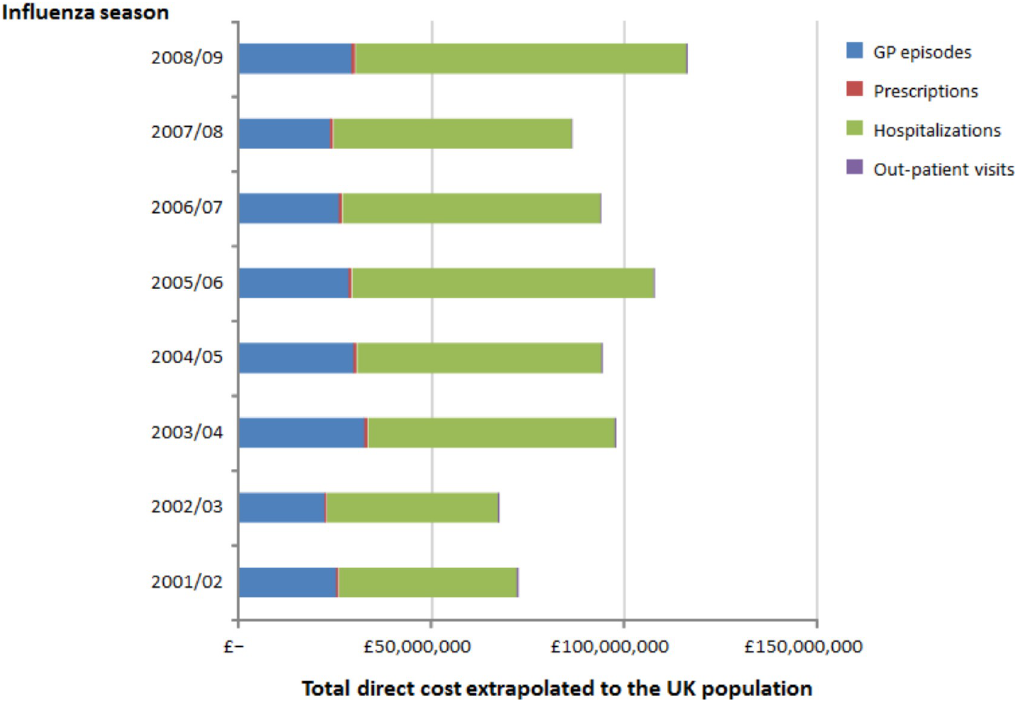
Fig 1. Resource use for acute respiratory illness in the CPRD/HES by influenza season extrapolated to the UK population for corresponding years.